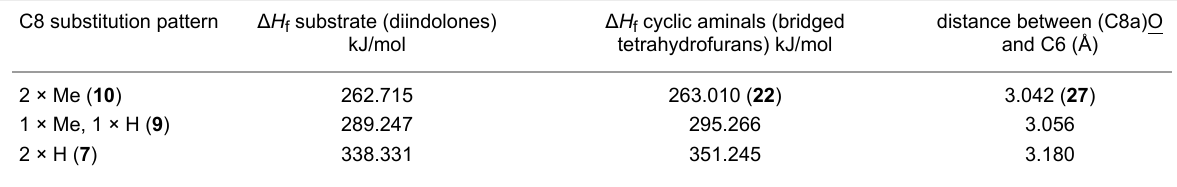
Table 1: Calculated values of Δ H f of the red diindolone substrate 10 and the bridged tetrahydrofuran product 22 , plus the distance between nucleo- phile (O) and electrophile (C) in the proposed key reaction intermediate, structure 27 , together with comparison data for analogous structures from 9 and 7